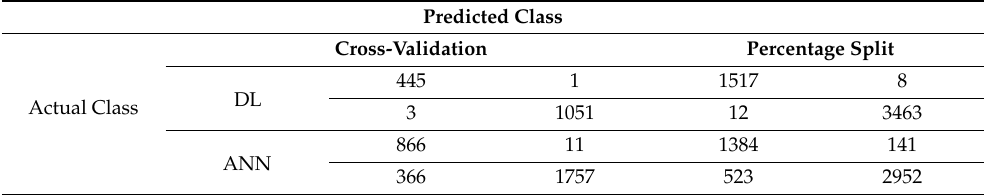
Table 7. Confusion matrices results when DL versus ANN were used for different number of samples.